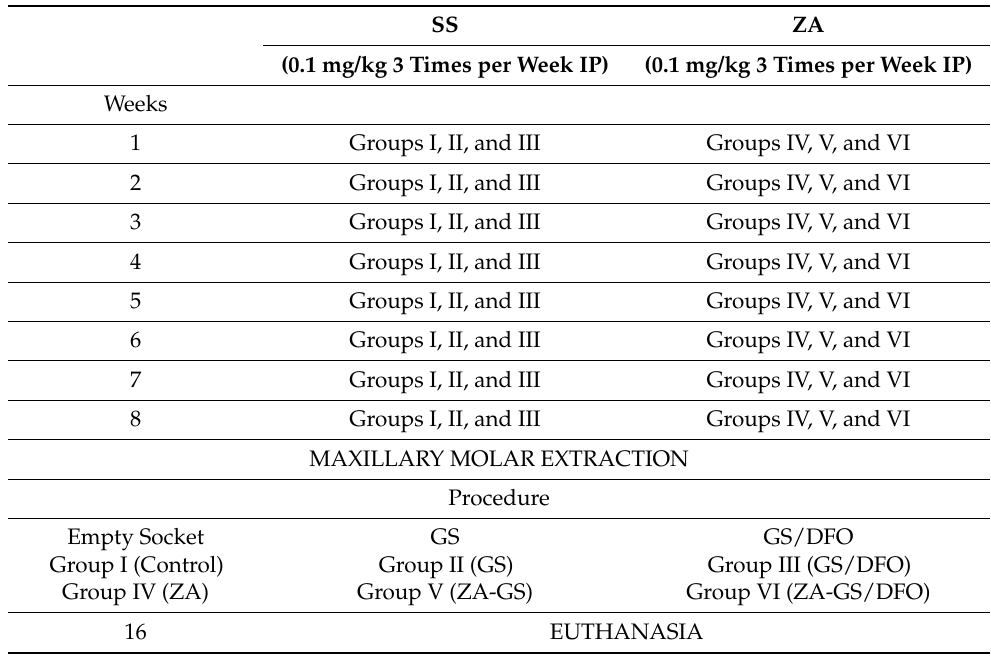
Table 1. Procedures applied to rats in the control and experimental groups weekly. Abbreviations: SS: Sterile Saline; ZA: Zoledronic Acid; GS: Gelatin Sponge; DFO: Deferoxamine; IP: